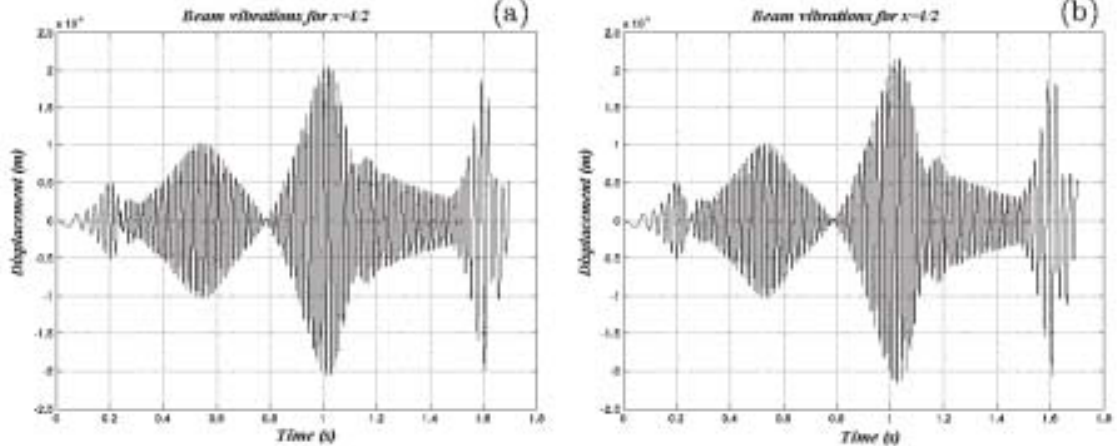
Fig. 4. Beam half-point vibrations: a) ‘ideal’ force control, b) SMC force